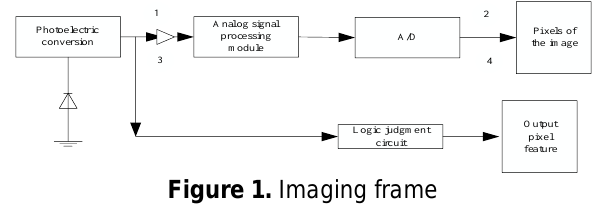
Figure 1. Imaging